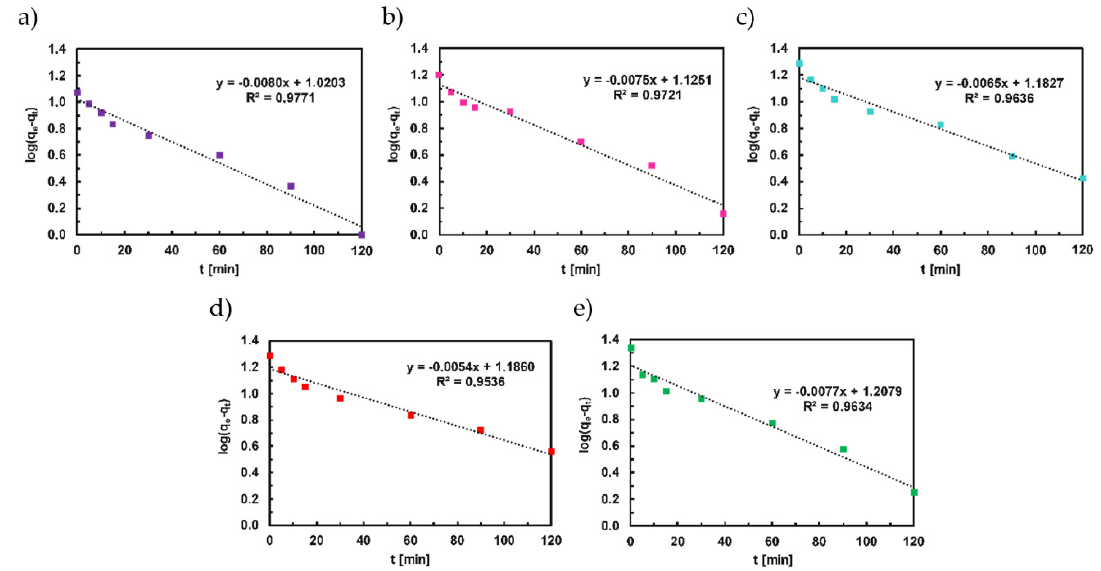
Figure 16. Adsorption data modeled using kinetic Lagergren’s pseudo-first-order law for ( a ) Fe 3 O 4 , ( b ) Fe 3 O 4 @1%Zn, ( c ) Fe 3 O 4 @2%Zn, ( d ) Fe 3 O 4 @5%Zn, and ( e ) Fe 3 O 4 @10%Zn nanoparticles in pH equal 6.